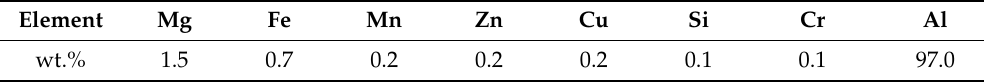
Table 1. The chemical compositions (in wt.%) of 5005 Al alloy.